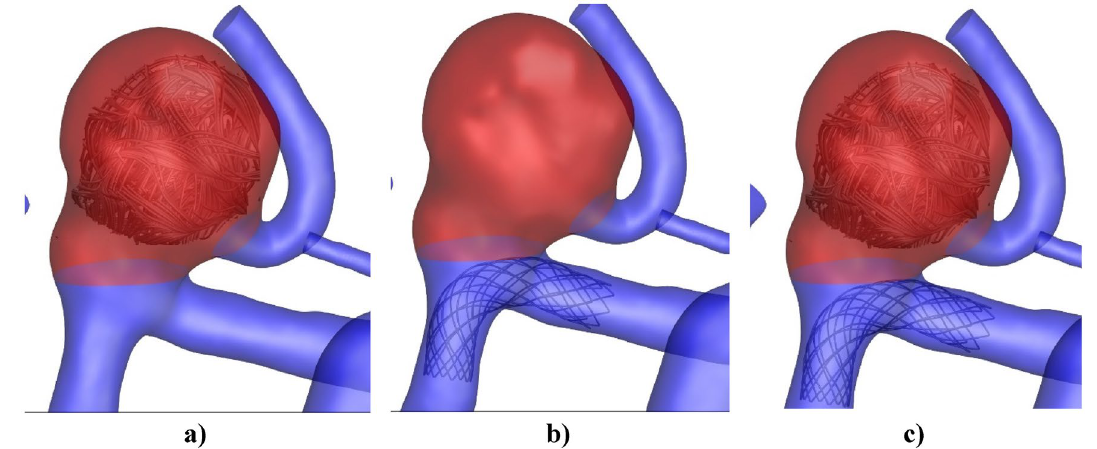
Figure 1. MCA aneurysm with ( a ) coiling ( b ) fiber-based stents stent ( c ) coiling and